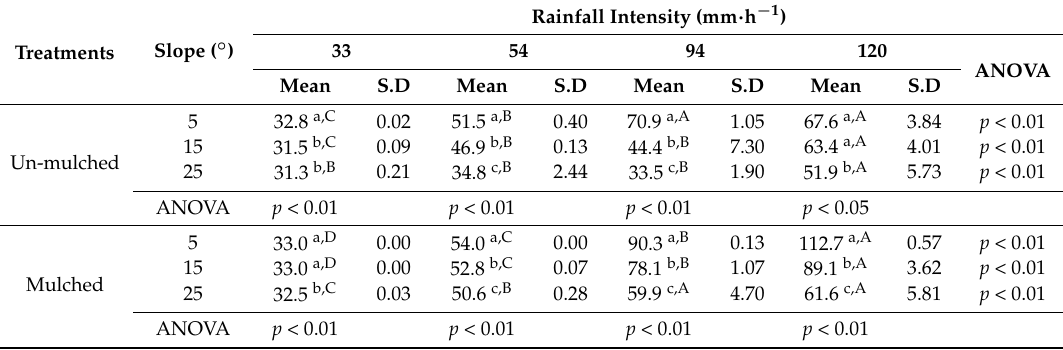
Table 3. Mean water infiltration (mm · m − 2 ) values under various rainfall intensities and slope levels in un-mulched and mulched